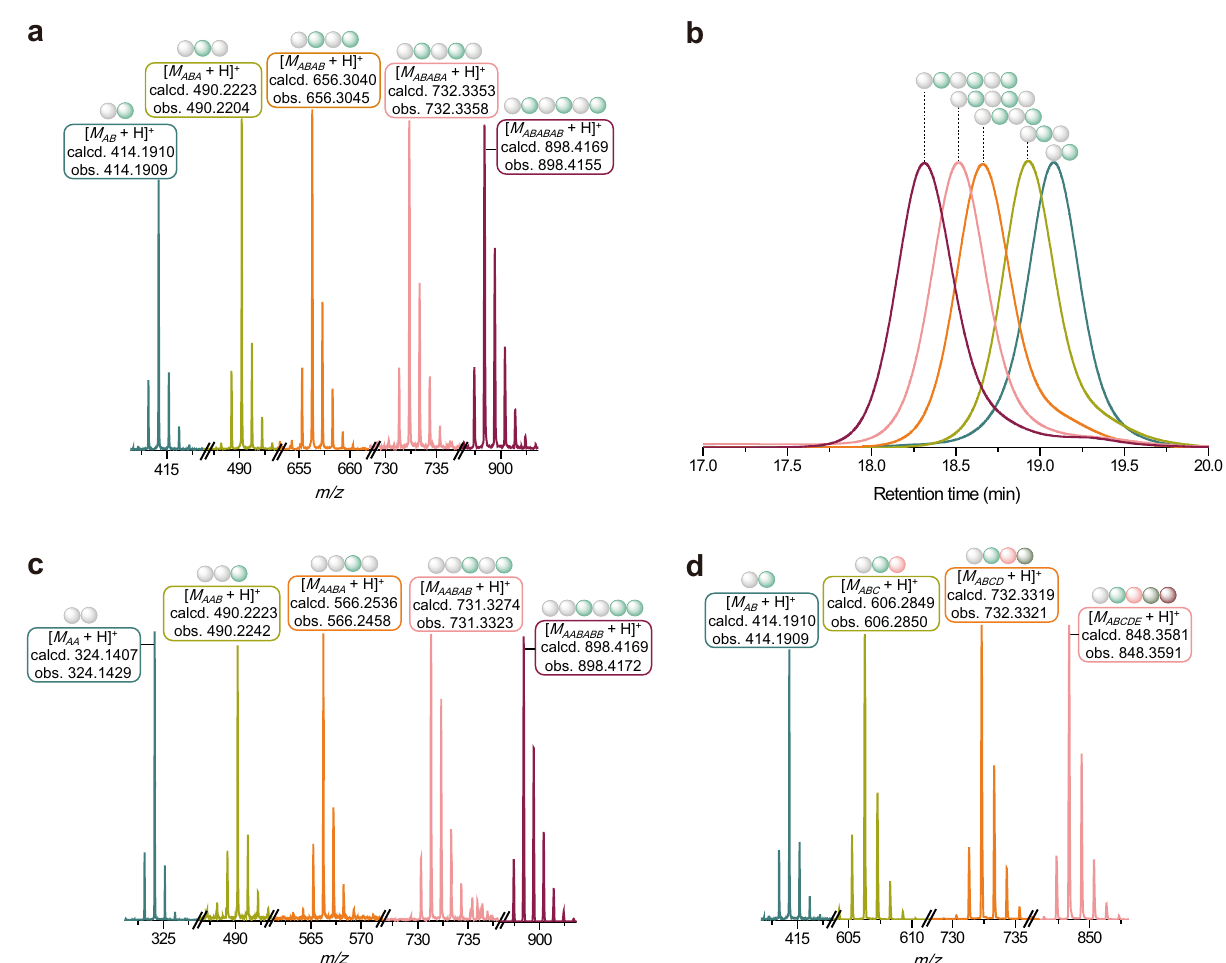
Fig. 3 Synthesis and characterization of discrete oligomers ABABAB, AABABB, and ABCDE. a Conjoined high-resolution mass spectra of discrete oligomers in the synthesis of hexamers ABABAB. b GPC traces of discrete oligomers in the synthesis of hexamers ABABAB. c Conjoined high-resolution mass spectra of discrete oligomers in the synthesis of hexamers AABABB. d Conjoined high-resolution mass spectra of discrete oligomers in the synthesis of hexamer